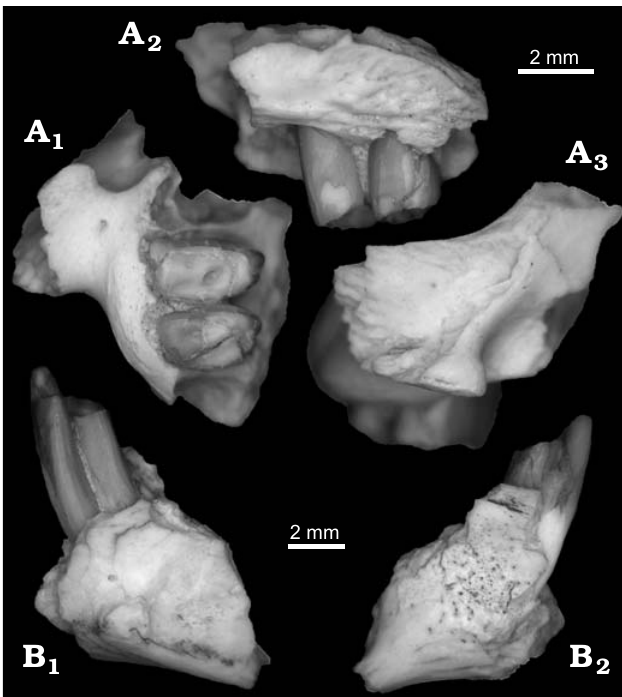
Fig. 8. Lagomorph Gobiolagus aliwusuensis Fostowicz-Frelik, Li, Meng, and Wang, 2012 from the Eocene of Wulanhuxiu, Nei Mongol, China. A . Fragment of the right maxilla with M1–M2 (IVPP V20262) in ventral (A 1 ), medial (A 2 ), and lateral (A 3 ) views. B . Left m2 in mandible fragment (IVPP V20263.2) in buccal (B 1, note the knob-like masseteric tubercle un- der the trigonid) and lingual (B 2 ) views.